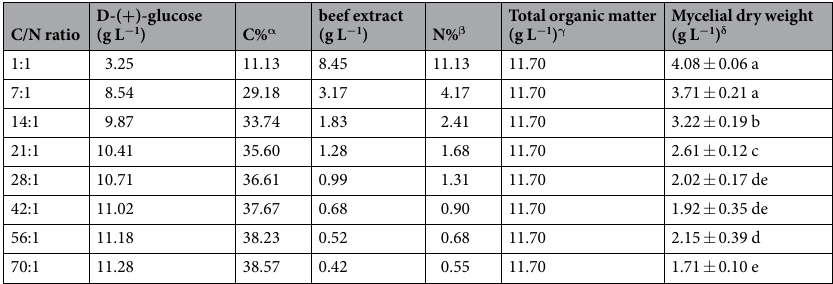
Table 8. Effect of C/N ratio on the mycelial growth of Isaria farinosa . α The carbon content of D-( + )-glucose was 40% based on the chemical formula of C 6 H 12 O 6 . C% equals the amount of D-( + )-glucose (g L − 1 ) × 40%/ total organic matter. β The nitrogen content of the beef extract was determined as 15.41% by the Kjeldahl method. N% equals the amount of beef extract (g L − 1 ) × 15.41%/total organic matter. γ Total organic matter represents the total dry weight (g) of D-( + )-glucose and beef extract in 1 L of medium. δ Mean ± SE. Values followed by the same letters within a column do not differ significantly (ANOVA, P = 0.05).